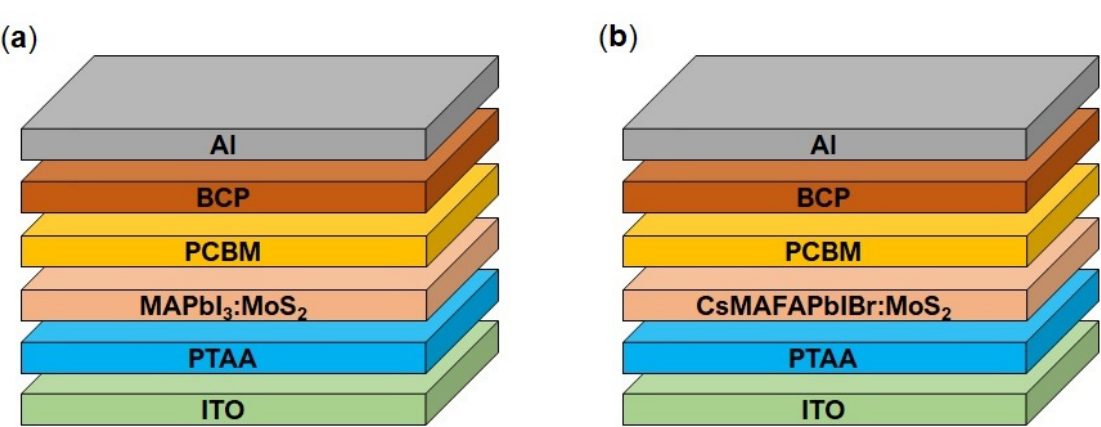
Figure 1. ( a ) Schematic p -i-n architectures of the MAPbI 3 :MoS 2 and ( b ) CsMAFAPbIBr:MoS 2 PSCs.